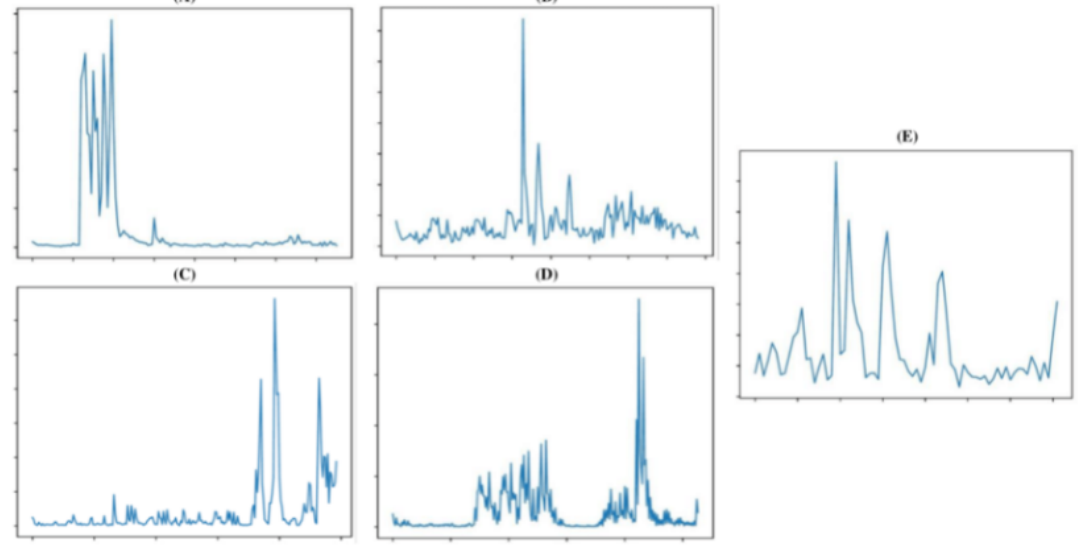
Figure 7. (A) Short 4-peak burst—rebound phenomenon TOF-like pattern after a single movement, short intertwitch distance; (B) T3 less than T2 and T4; (C) Almost equidistant oscillations; (D) Crescendo pattern; (E) Decrescendo but gross oscillations and variable interpeak distance. Some of